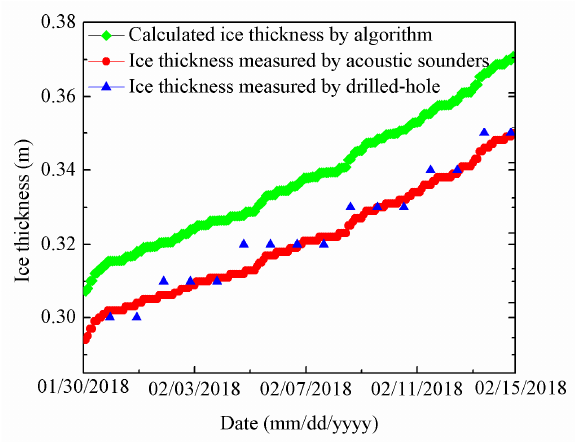
Figure 21. Calculated ice thickness by algorithm ( green lines ), ice thickness measured by acoustic sounders ( red lines ), and ice thickness measured by drilled-hole ( blue triangles ) from 30 January to 15 February.